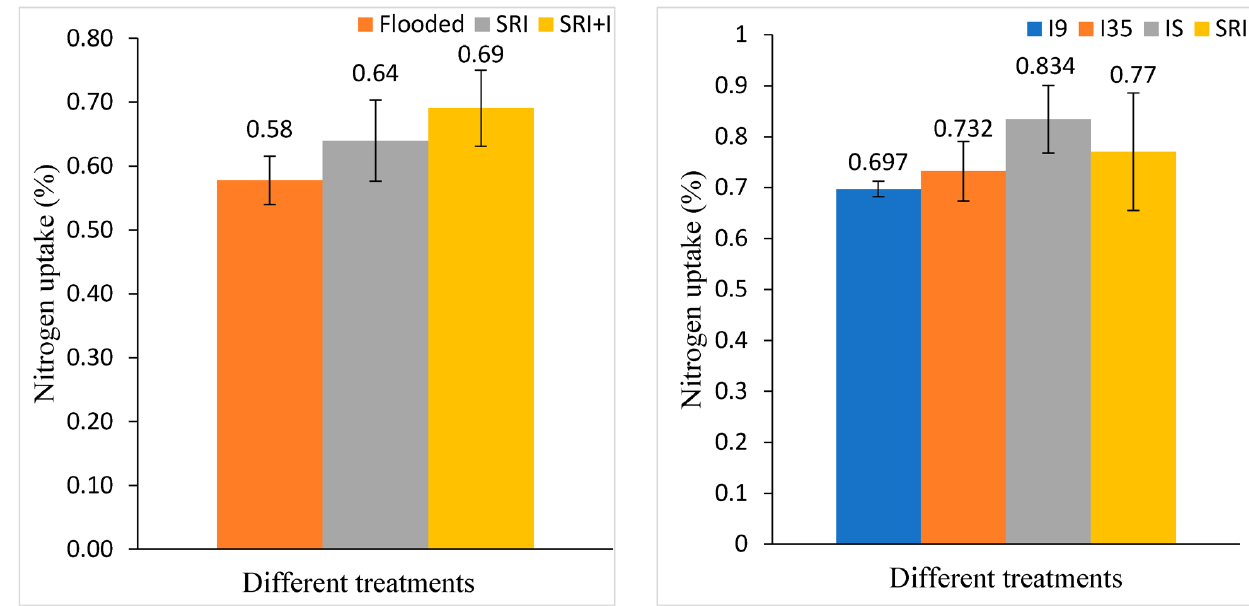
Figure 9. Nitrogen uptake as measured in the different treatments. Conventional flooded rice (CFR), SRI, and SRI with intercropping (SRI+I or SRIBI) in 2017 ( Left ). SRI and three different intercropping configurations in 2018 ( Right ).